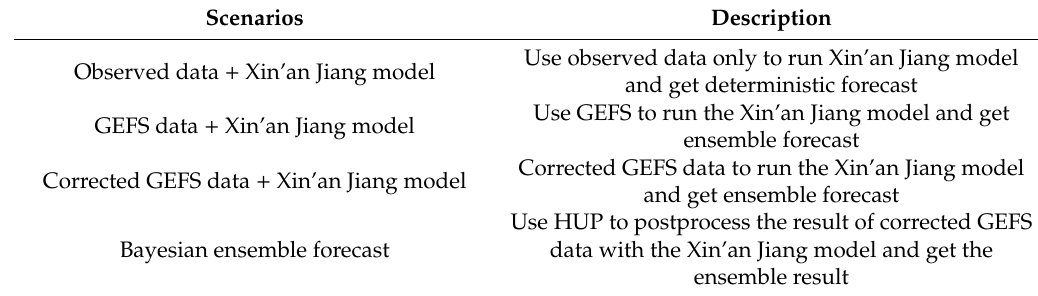
Table 6. Brief descriptions of the four